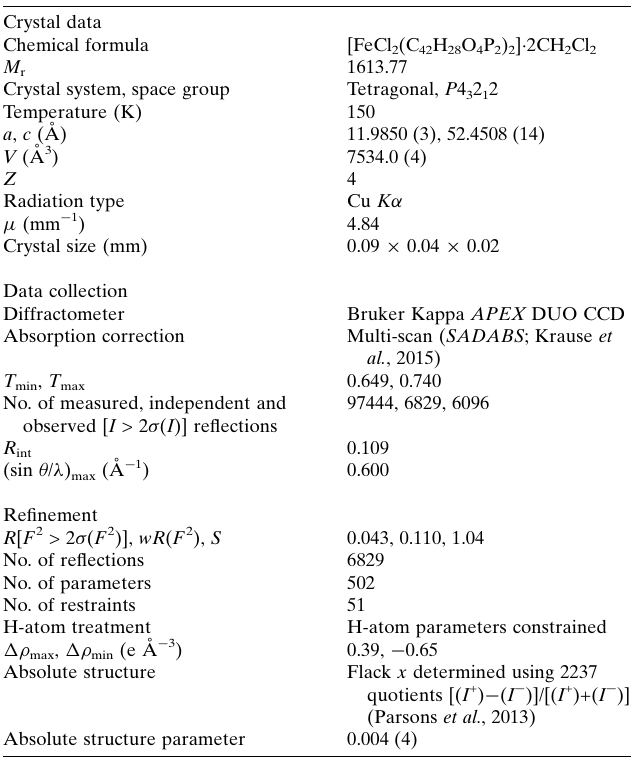
Table 3 Experimental details. Crystal data Chemical